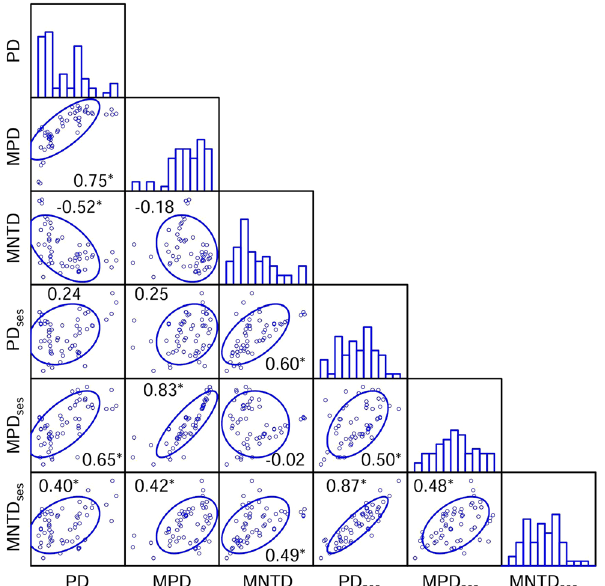
Figure 2. Histogram of each phylogenetic metric and relationships between phylogenetic metrics. An ellipse includes 75% of the sample. The center of each ellipse is the sample mean of the x and y variables in the plot, and its axes are determined by the standard deviations of x and y . Values are Pearson’s correlation coefficients ( * Indicating P <